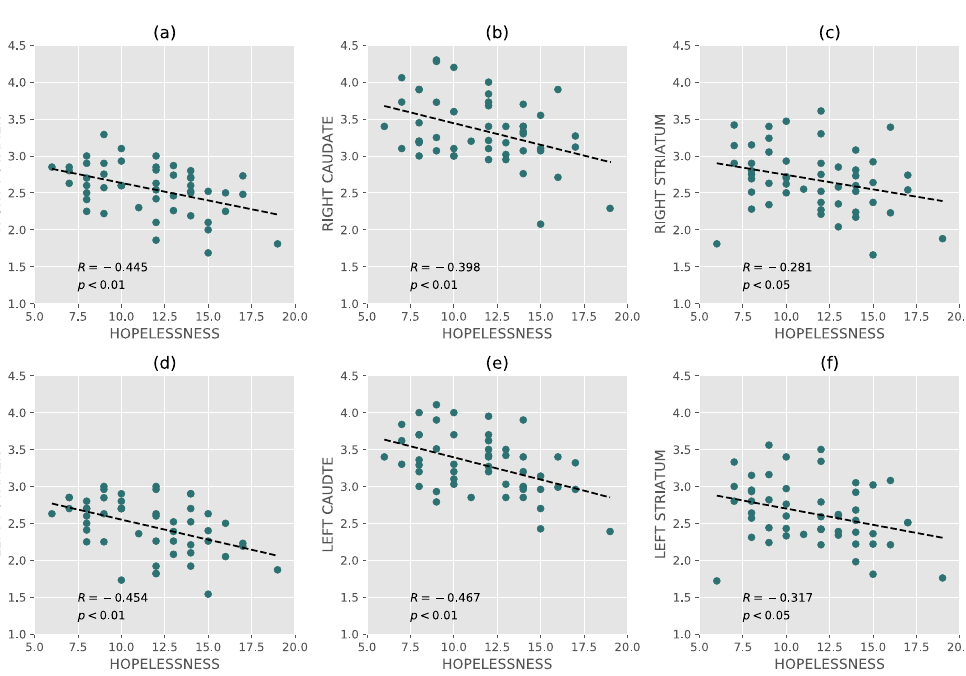
Figure1. Correlationsbetweenhopelessnessanddopaminetransporter. ( a ): Correlationbetweenhopelessness Figure 1. Correlations between hopelessness and dopamine transporter. (a): Correlation between and right putamen. ( b ): Correlation between hopelessness and right caudate. ( c ): Correlation between hopelessness and right putamen. (b): Correlation between hopelessness and right caudate. (c): Correlation hopelessness and right striatum. ( d ): Correlation between hopelessness and left putamen. ( e ): correlation between hopelessness and right striatum. (d): Correlation between hopelessness and left putamen. (e): betweenhopelessnessandleftcaudate. ( f ): Correlationbetweenhopelessnessandleftstriatum. Thecorrelation correlation between hopelessness and left caudate. (f): Correlation between hopelessness and left striatum. coefficients and p-values are reported for each The correlation coefficients and p-values are reported for each plot.